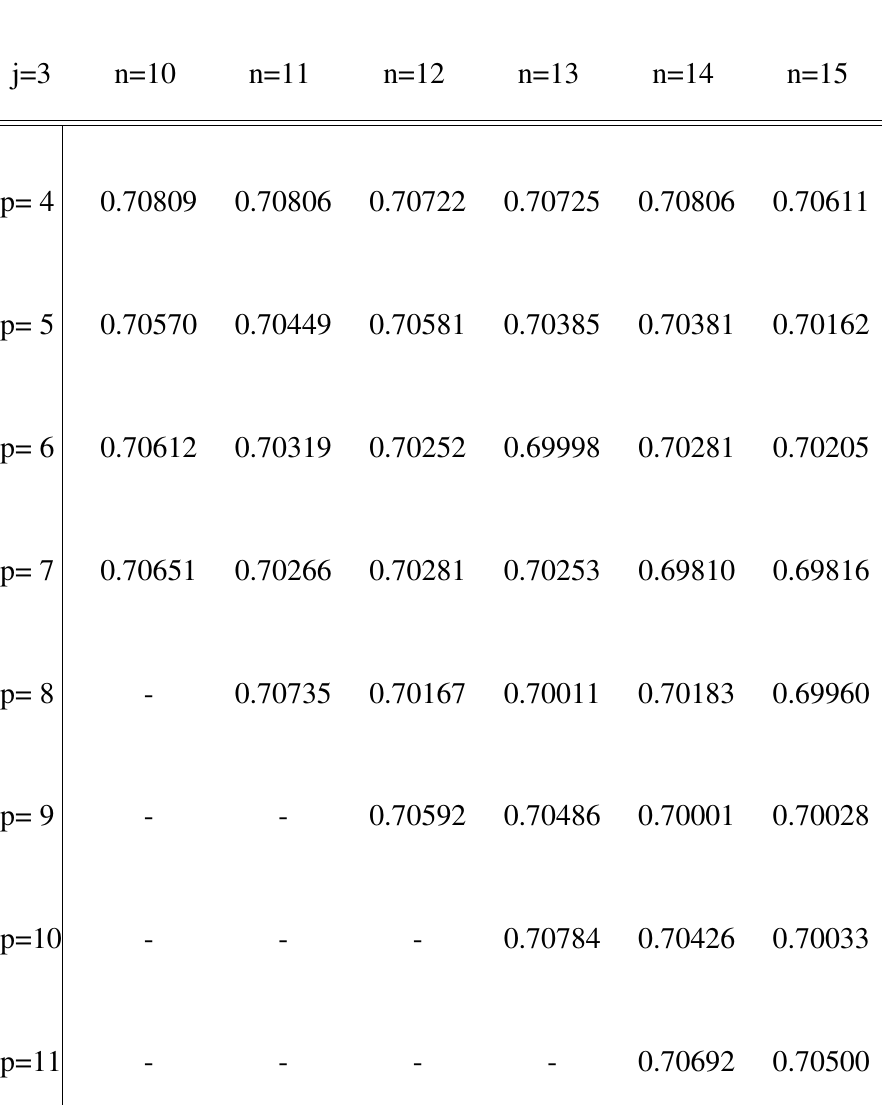
Table 2: Average Value of Dominance for different values of n and p for j = 3 sigma = 1